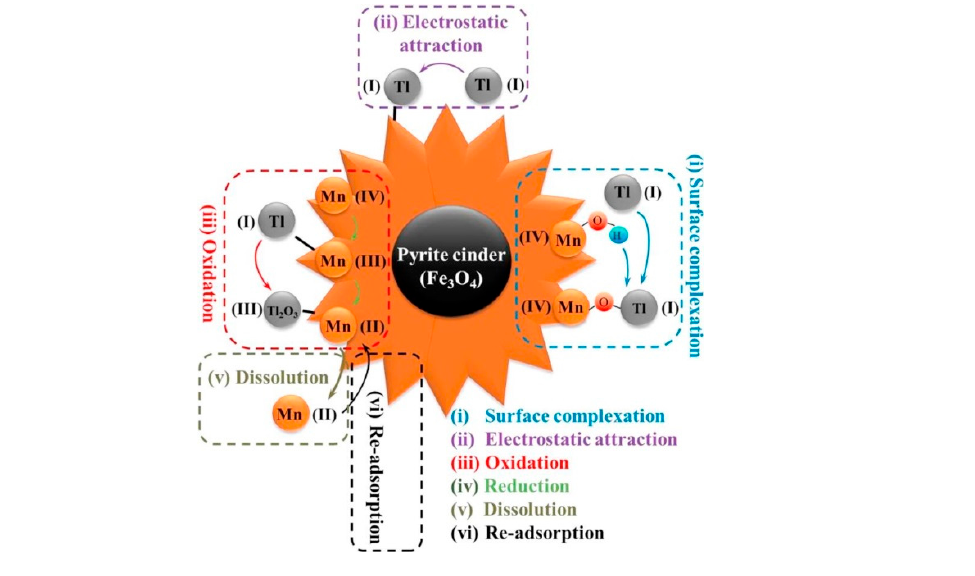
Figure 5. Mechanism diagram for the adsorption of Tl(I) by MnO 2 @pyrite cinder [35]. Table 2. Iron oxide removal thallium performance and its advantages and